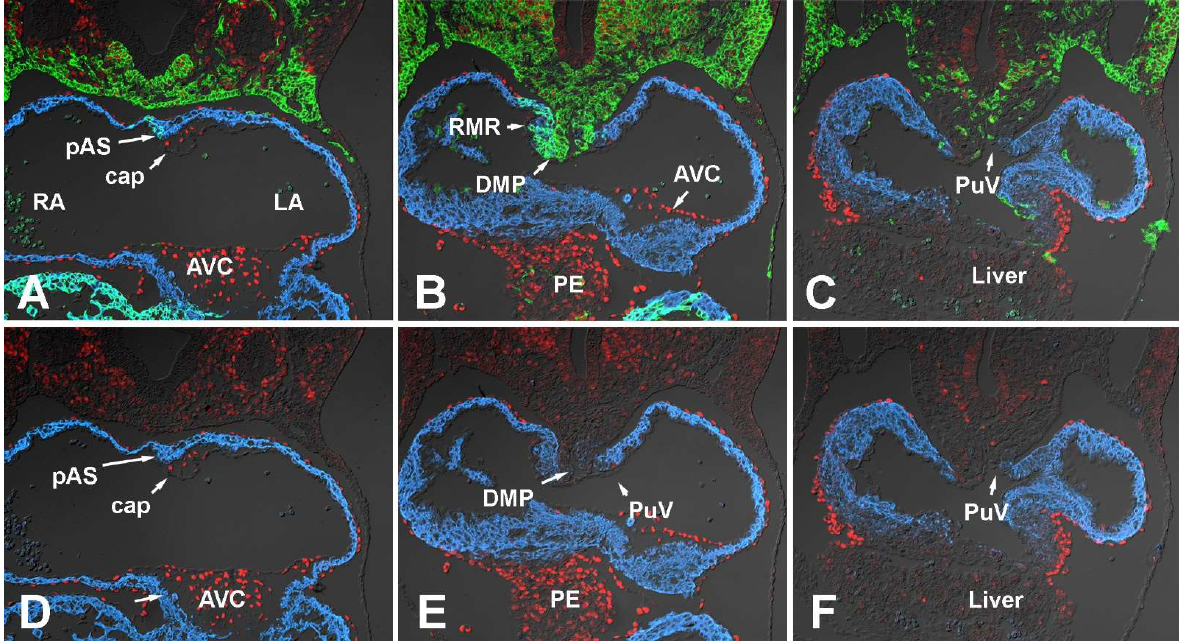
Figure 3. Sox9 expression at embryonic day 10.5. Panels ( A – C ) show serial sections of embryonic SHFcre;R26mG hearts at ED10.5 immunofluorescently stained for the presence of Sox9 (red), Myosin Heavy Chain (blue), and GFP (green). The GFP staining delineates the SHF and SHF-derived cells. In ( D – F ), only the Myosin Heavy Chain (blue) and Sox9 (red) are shown to more clearly show the Sox9 distribution. AVC = atrioventricular cushion, cap = mesenchymal cap, DMP = dorsal mesenchymal protrusion, PE = proepicardium, LA = left atrium, LV = left ventricle, pAS = primary atrial septum. PuV = pulmonary vein, RA = right atrium, RMR = right mesocardial reflection, RV = right ventricle.